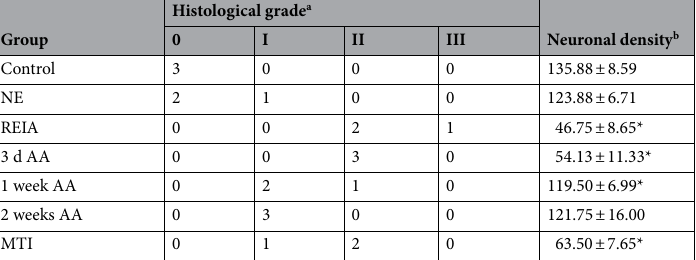
Table 1. The histological grade (HG) and pyramidal neuronal density (ND) of the cerebral motor cortex of rats in each group. *P < 0.05 vs. the control group. (ANOVA with post hoc Bonferroni correction; n = 3 per group.) a Data indicate case numbers. b Data are presented as the mean ± SD of cells/high power field (HPF).